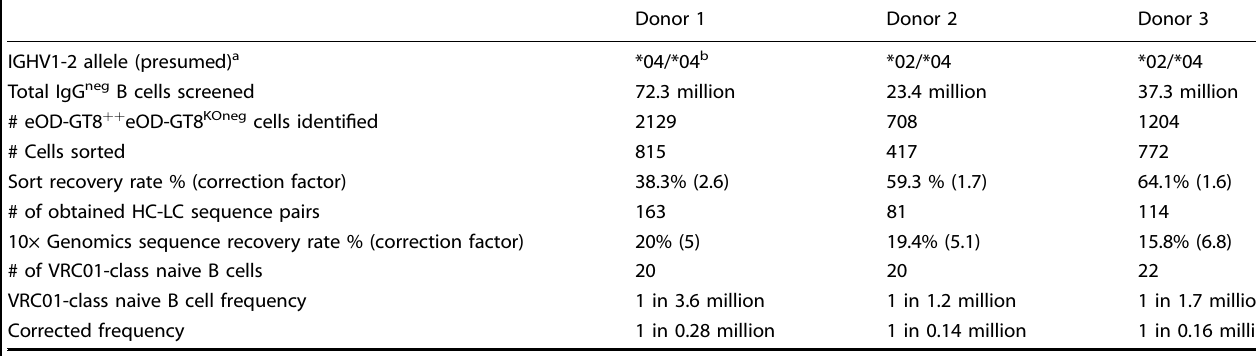
Table 2. VRC01-class naive B cell precursor frequency calculated for cells sorted with eOD-GT8